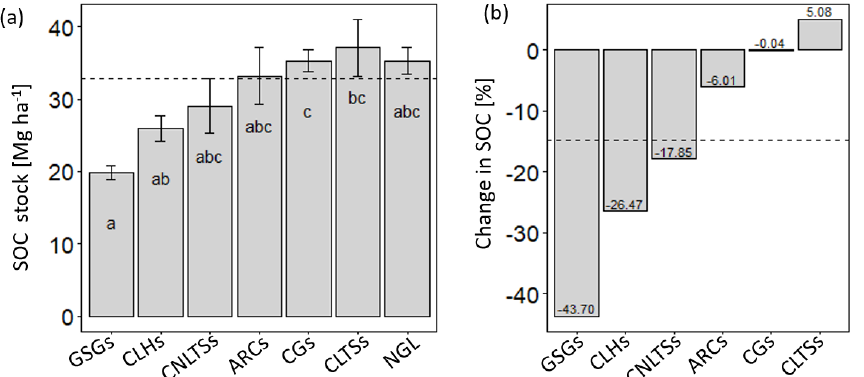
Figure 3. Bar plots (mean with error bars – SEM) of SOC stocks (a) and percent changes in SOC stocks (b) due to native grassland conversion under different land use scenarios. Different lowercase letters indicate significant differences between the land use types ( p< 0 . 05; se –